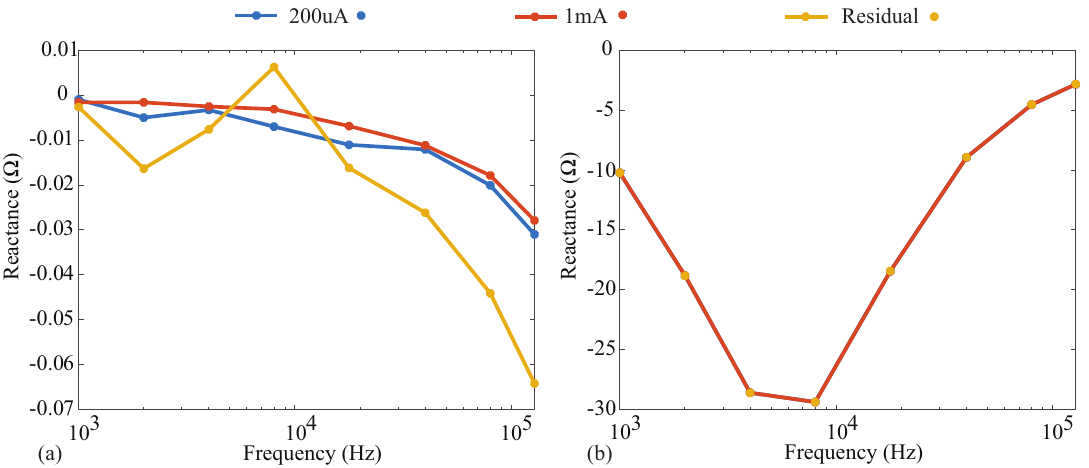
Figure A3. ( a ) Measured reactance of the 110 Ω resistor and ( b ) 2 R − 1 C Model 1 when the Keysight E4990A was configured for 1 mA, 200 µA, and approximately 8 µA (using a current-limiting